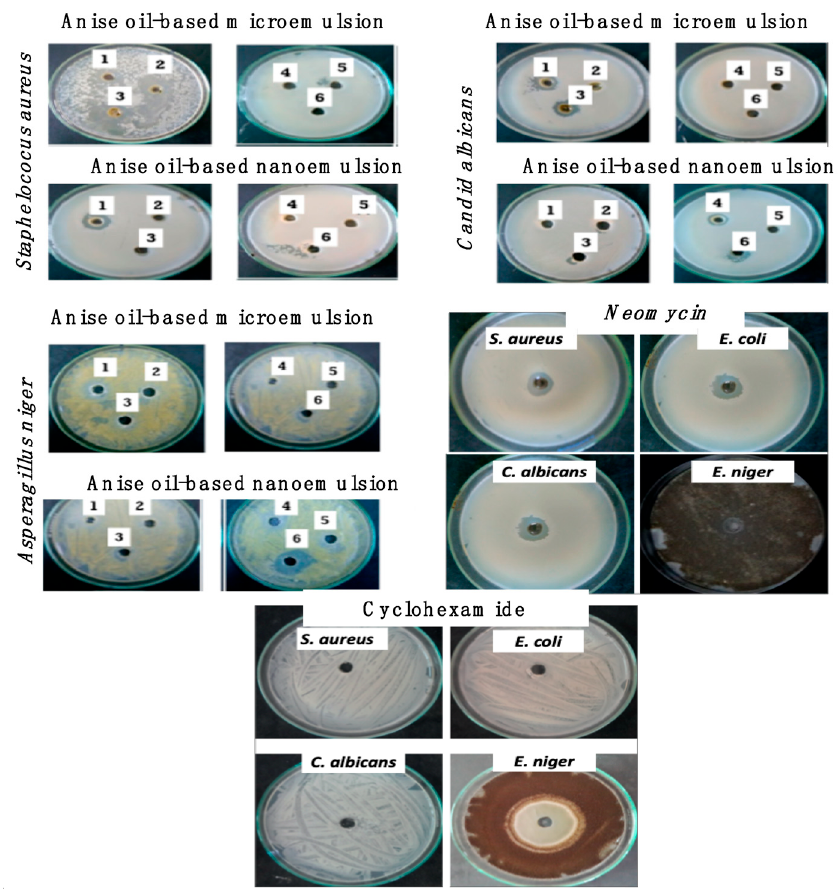
Figure 5. The antimicrobial activities of different concentrations of anise oil-based nanoemulsion against different test microbes as well as antimicrobial references. Table 3. MIC and MBC of different concentrations of anise oil-based nanoemulsion against all tested microbes. Sample